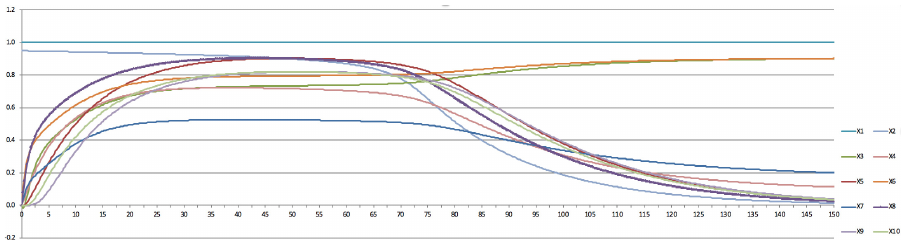
Fig. 8. Simulation results of working under an extremely stressful condition at the beginning (Scenario 4):